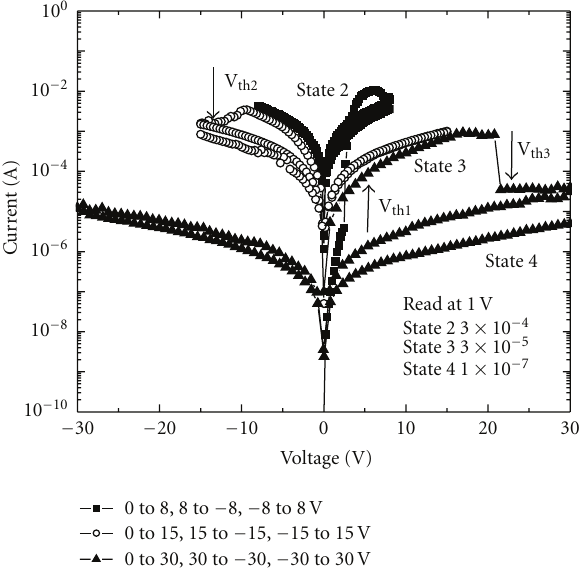
Figure 6: I-V response ofan Al/PMMA(22nm)/Almemorydevice. In addition to the threshold voltage at 2V, threshold voltages at − 12 and 20V are